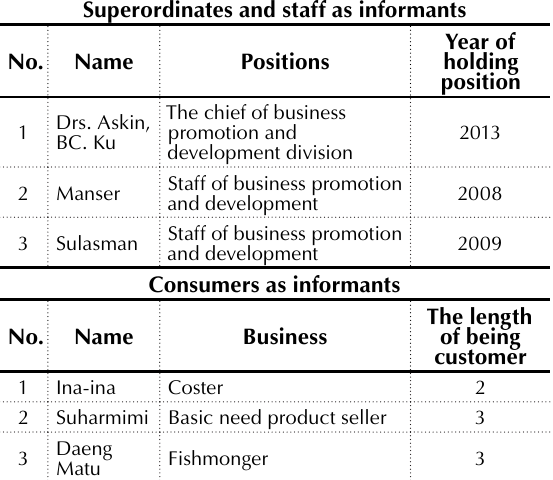
Table 1. The list of research informants Superordinates and staff as